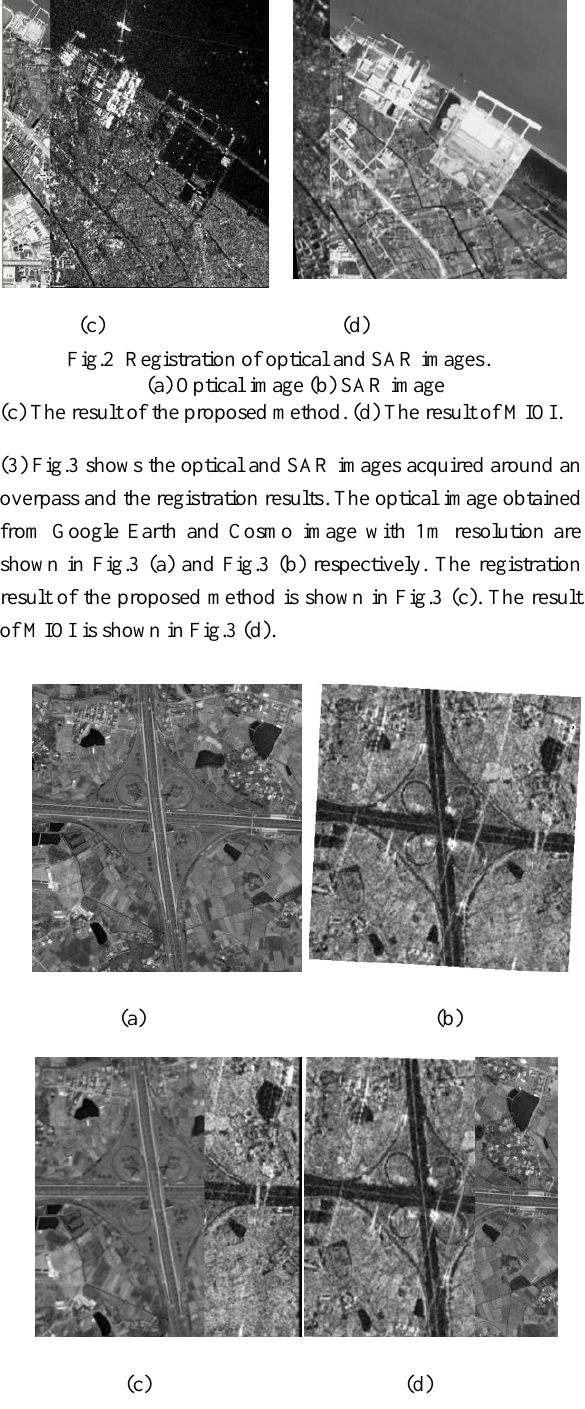
Fig.3 Registration of optical and SAR images. (c) The result of the proposed method. (d) The result of MIOI. As shown above, better results are acquired by the improved method. In order to calculate the accuracy, RMSE of 10 pairs of corresponding points is employed , and it is defined